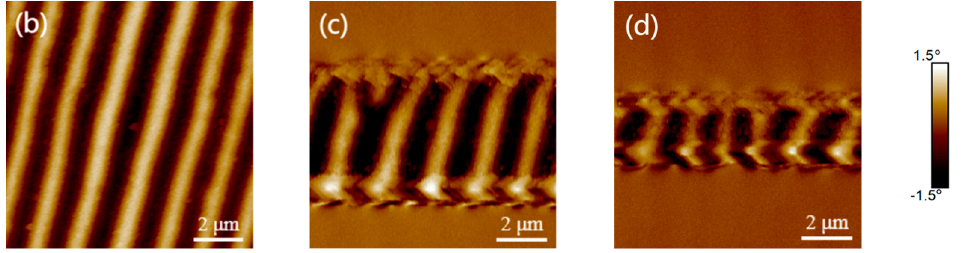
Figure 2. CoFeB stripe magnetic domain structure of stripe patterns with different line widths: ( a ) 100 µm × 100 µm, ( b ) 100 µm × 20 µm, ( c ) 100 µm × 5 µm, ( d ) 100 µm × 2 µm.